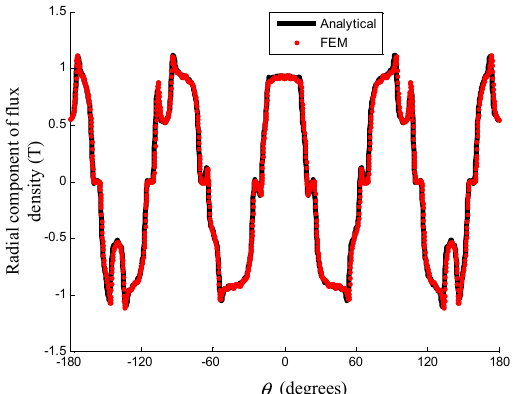
Figure 6. Radial magnetic flux density due to just PMs in the middle of the air-gap, when the rotor position is set to zero.